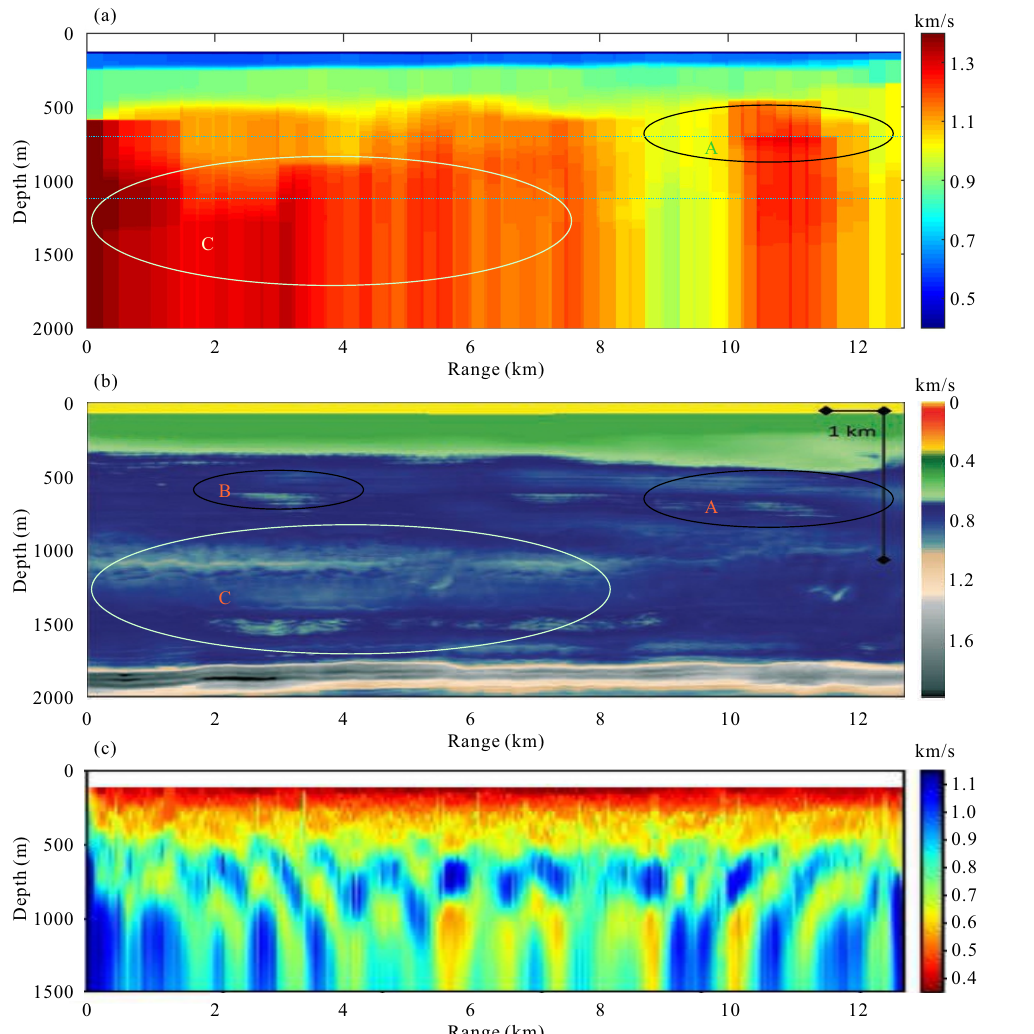
Figure 9. ( a ) a vertical slice of the resolved mean shear-wave subsurface structure under the 10th cable counted from left to right of the PRMRA in Figure 1. The top white layer represents the water layer. The dashed lines indicate the horizontal slices used in Figure 10; ( b ) a vertical slice of the shear-wave subsurface structure from active-source reflection tomography [36]; ( c ) a vertical slice of the shear-wave subsurface structure from 1D Monte Carlo ambient noise tomography [37]. The circles in ( a , b ) mark the high-velocity